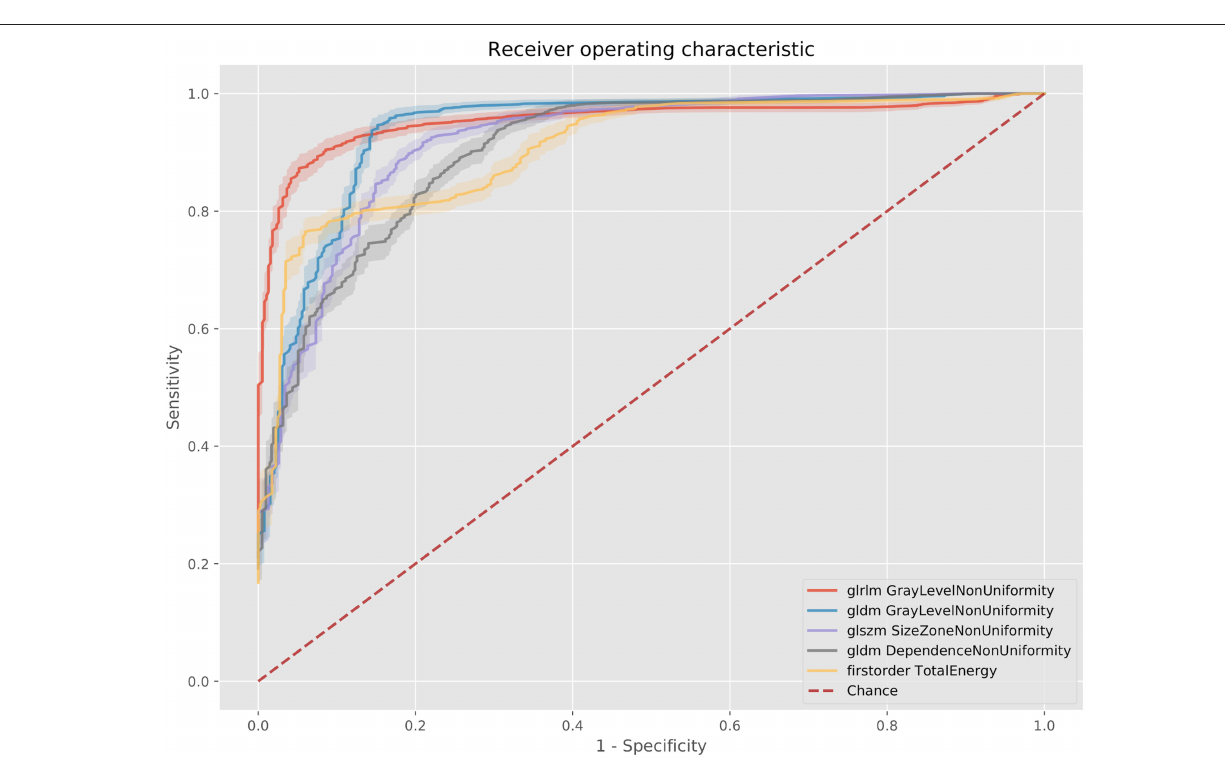
Frontiers in Cardiovascular Medicine |